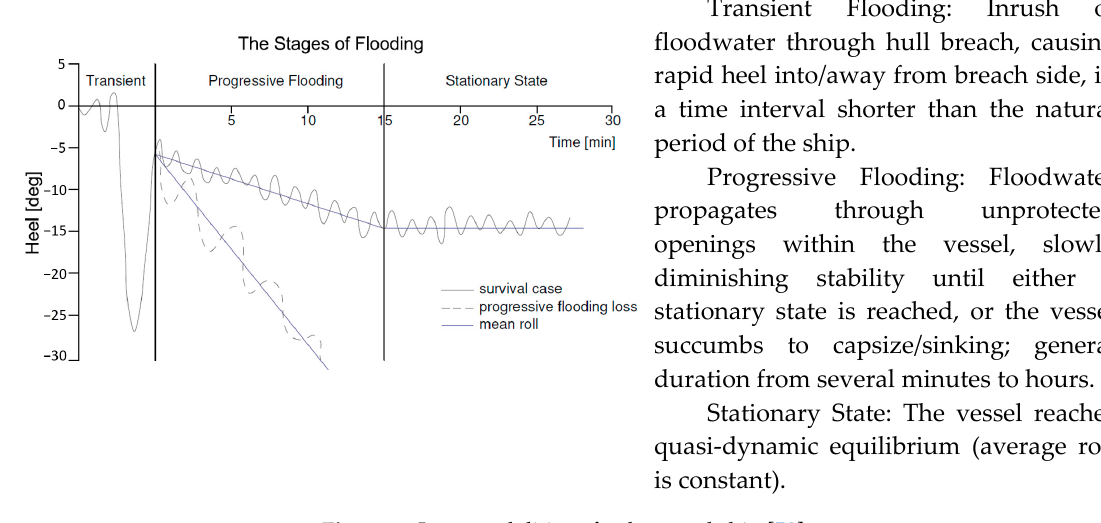
Figure 8. Loss modalities of a damaged ship [58].